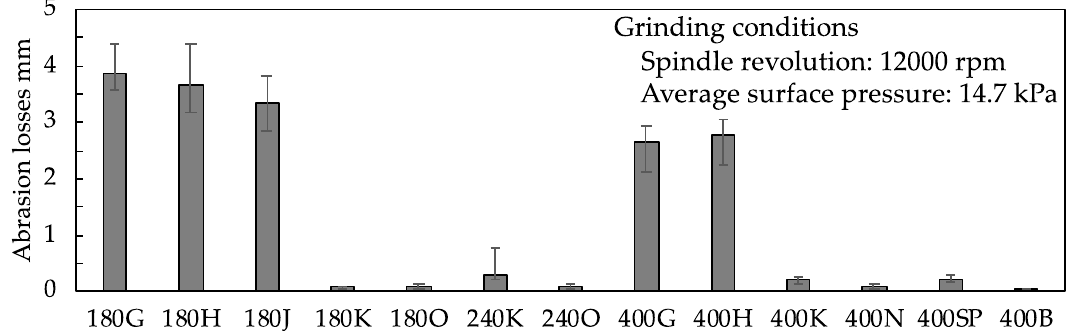
Figure 5. Average abrasion loss of the grinding wheel thickness after grinding.